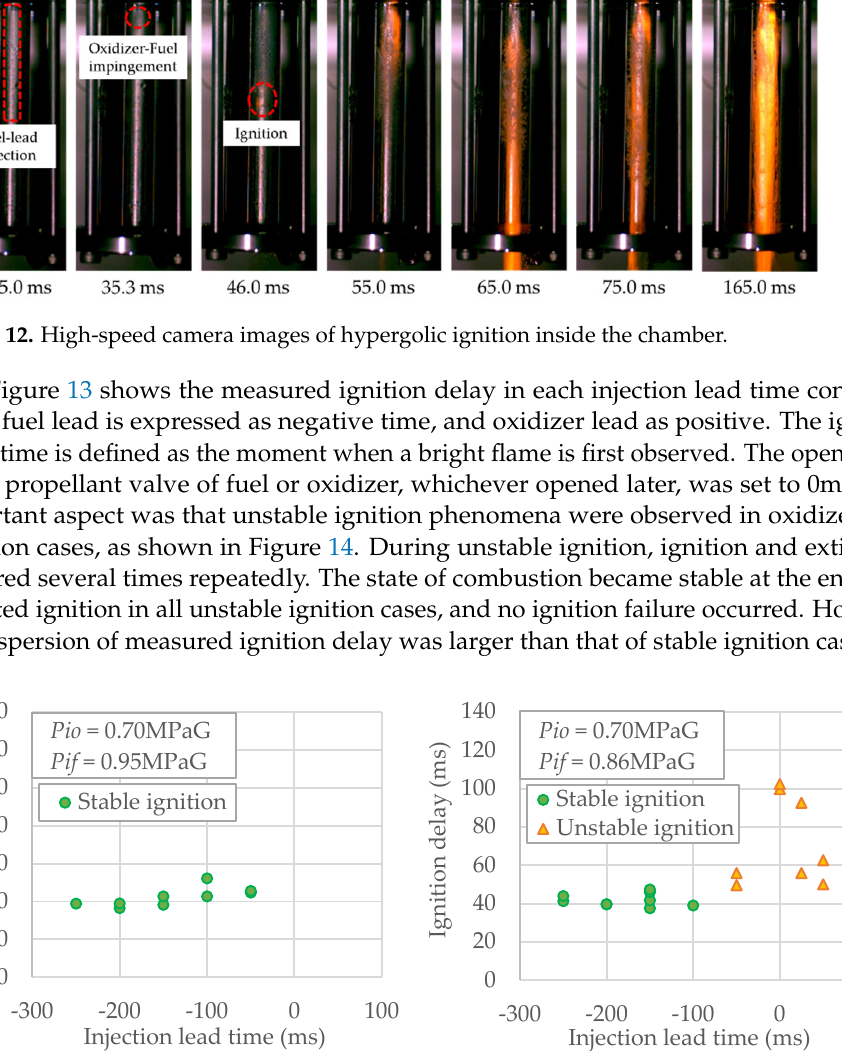
Figure 14. High ‐ speed camera images of unstable ignition.